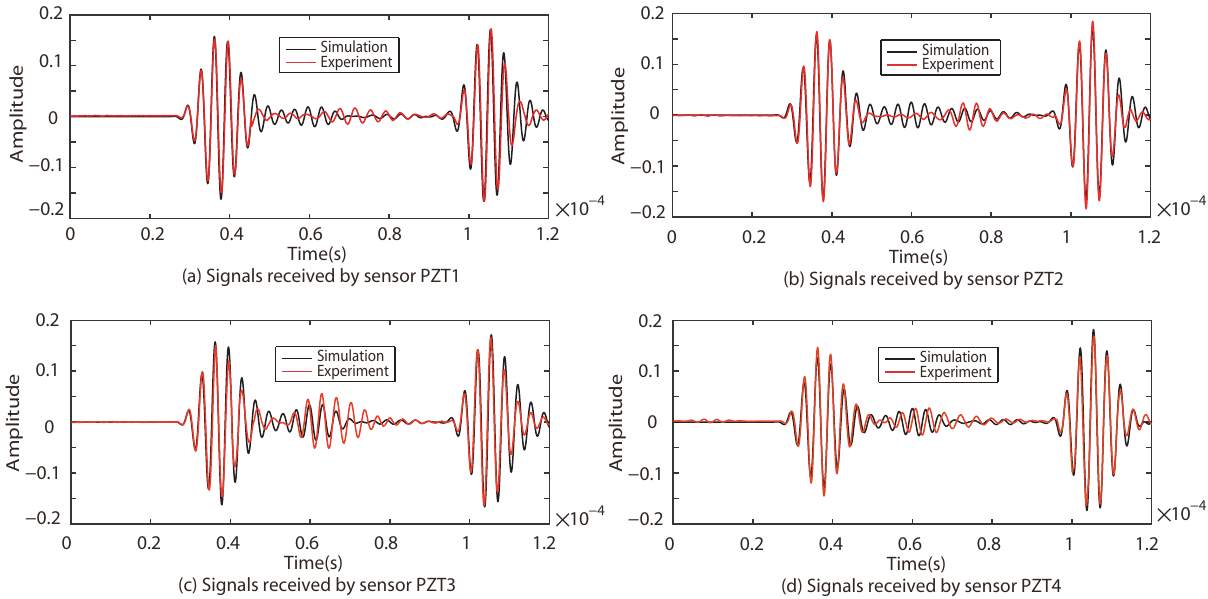
Figure 18. Comparison of experimental and simulation results under the center frequency of 300 kHz. As shown in Figures 16–18, the results of the simulations are in good agreement with those of the experiment. The signal processed by CWT is compared with the actual damage localization. When the center frequency is 200 kHz, only two groups of difference signals (PZT2-PZT4 and PZT3-PZT4) can be obtained. When the center frequency is 250 kHz and 300 kHz, three groups of difference signals (PZT1-PZT4, PZT2-PZT4 and PZT3-PZT4) can be obtained. Based on the above time-domain information, the predictions of damage center coordinates are obtained, as shown in Table 6. The absolute distance between the predicted damage center and the actual damage center is also given, as shown in Table